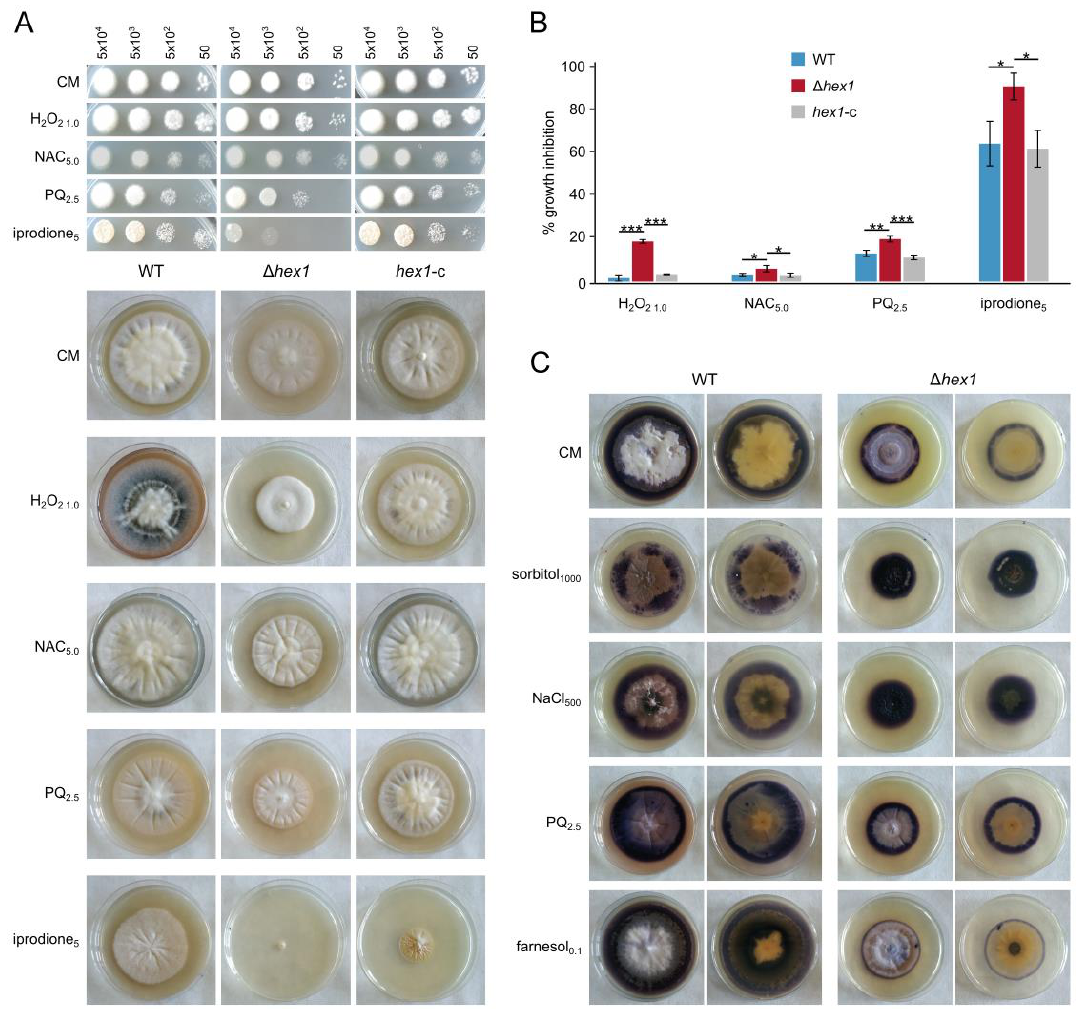
Figure 6. Effects of oxidative stress on Δ hex1 and its involvement in reactive oxygen species (ROS) metabolism. ( A ) Responses of the wild- type, the deletion (Δ hex1 ), and the complemented ( hex1 -c) strains to H 2 O 2 , paraquat, iprodione, and N -acetyl cysteine with regard to germination (top; the number of inoculated conidia per spot are provided above the images; growth for 3 days) and radial growth (bottom; growth for 18 days). CM: CzD-CM. ( B ) Relative growth inhibition by the same substances (each condition was tested in triplicate; bars = SD; statistical testing by one-way ANOVA followed by Tukey’s post hoc test (* p ≤ 0.05, ** p ≤ 0.01, *** p ≤ 0.001). All concentrations are given in mM, except for iprodione (μg/mL). ( C ) Detection of superoxide anion radicals (O 2 − ) using nitro blue tetrazolium chloride (NBT) staining in colonies of the two strains upon treatment with various sources of stress (NaCl, sorbitol, paraquat, and farnesol). Both top and bottom views of plates are shown for every treatment.